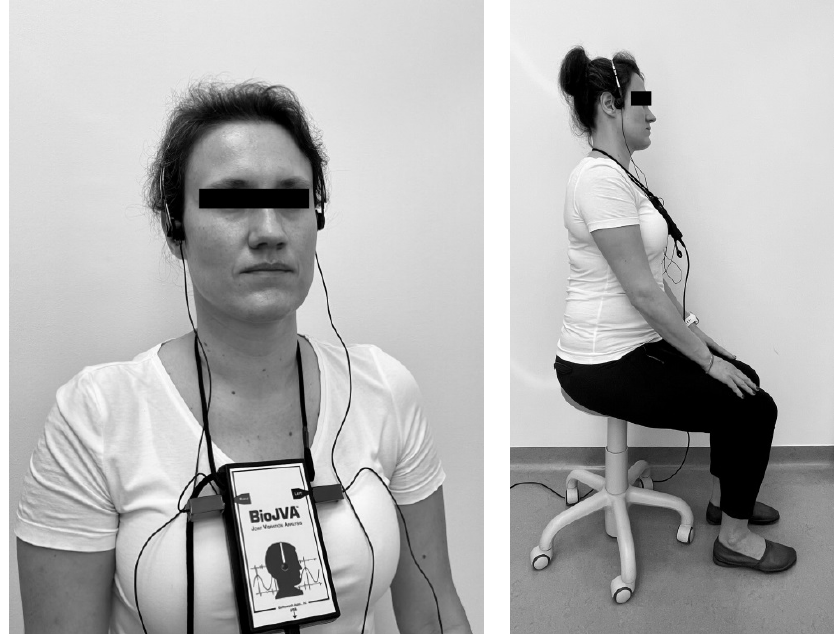
Figure 2. Position of the patient during the joint vibration recording procedure .